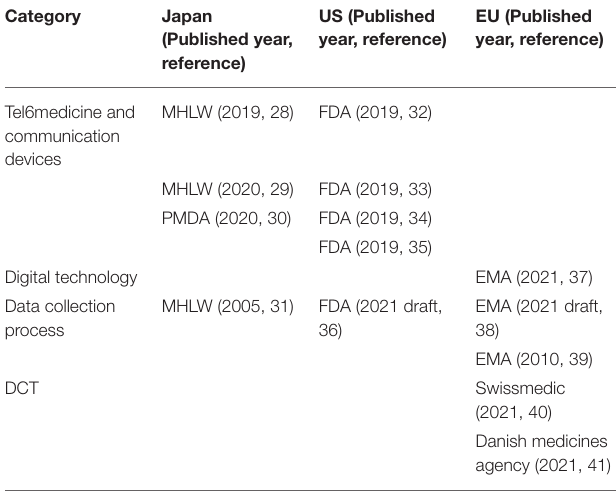
TABLE 3 | Therapeutic area of identified device/feature examples from sub-cluster.